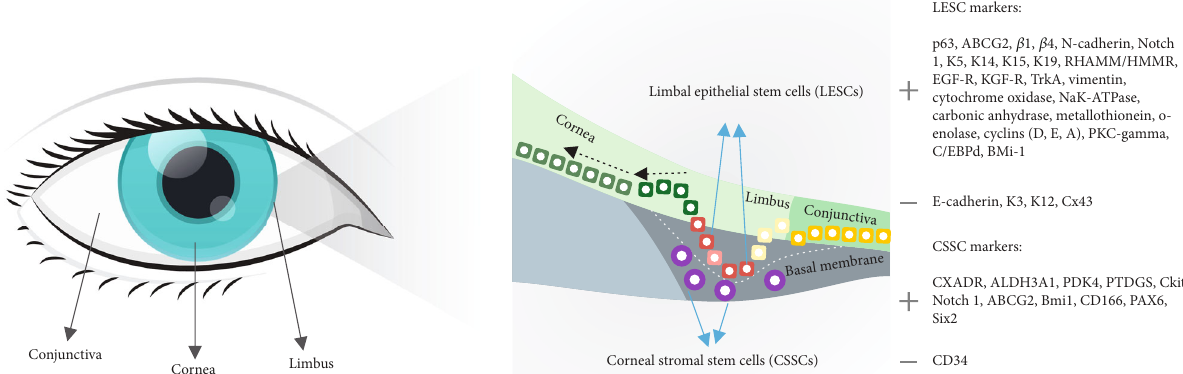
Figure 1: Localization and markers of LESCs and